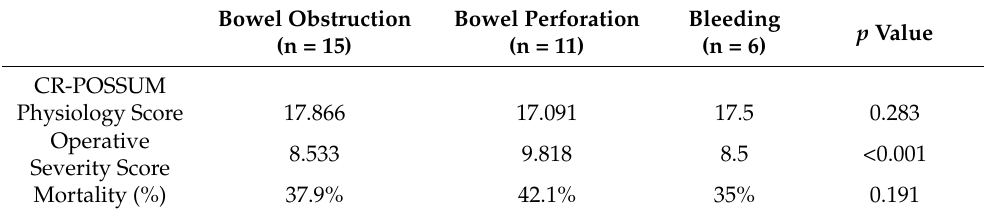
Table 4. CR-POSSUM in different clinical pictures. Significance test used is ANOVA